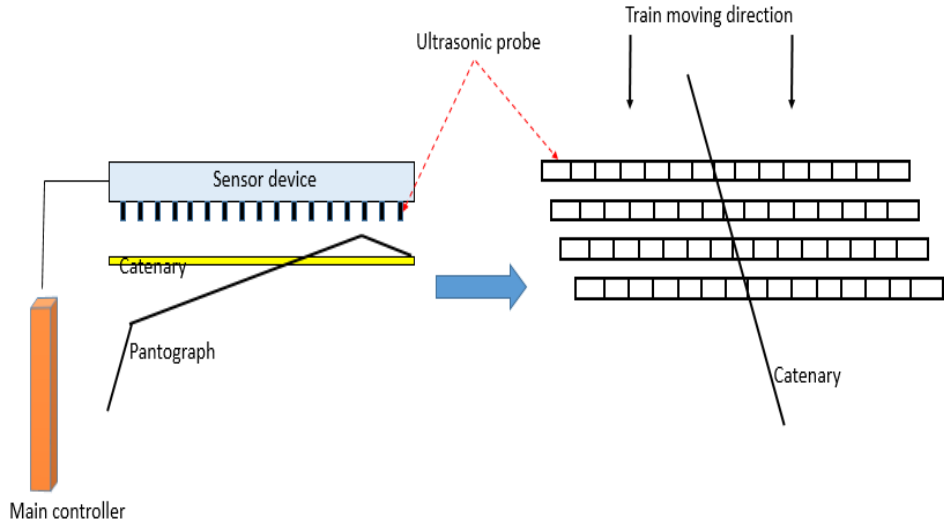
Figure 2. The principle of the ultrasonic measuring device.